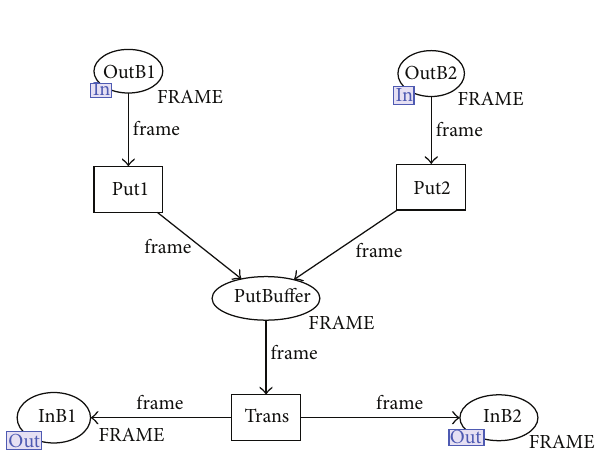
Figure 6: Channel module.